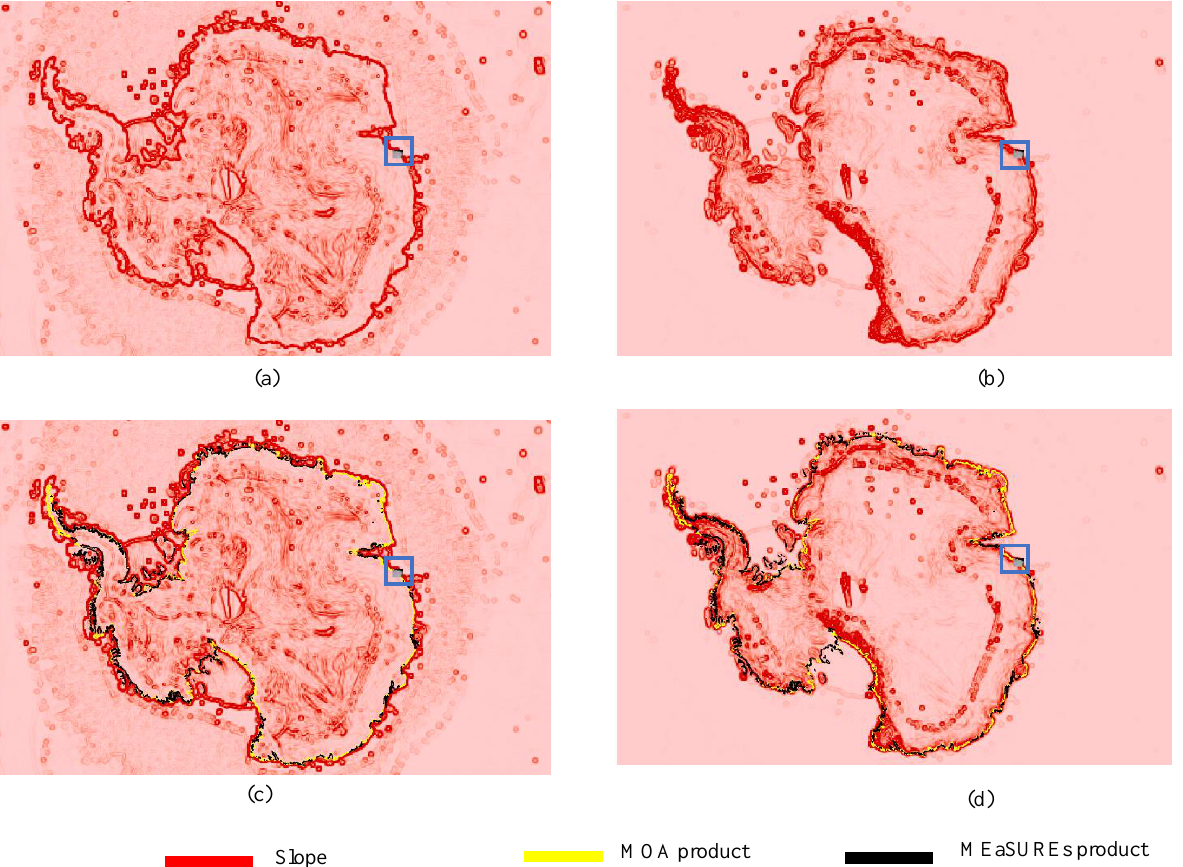
Fig.4.(a) the degree representation result;(b) the percentage representation result;(c) The result of the degree representation result extraction(the red line) , the existing Moa product(the yellow line) and the InSAR_GL_Antarctica product(the black line);(d) The result of the percentage representation result extraction(the red line) , the existing Moa product(the yellow line) and the InSAR_GL_Antarctica product(the black